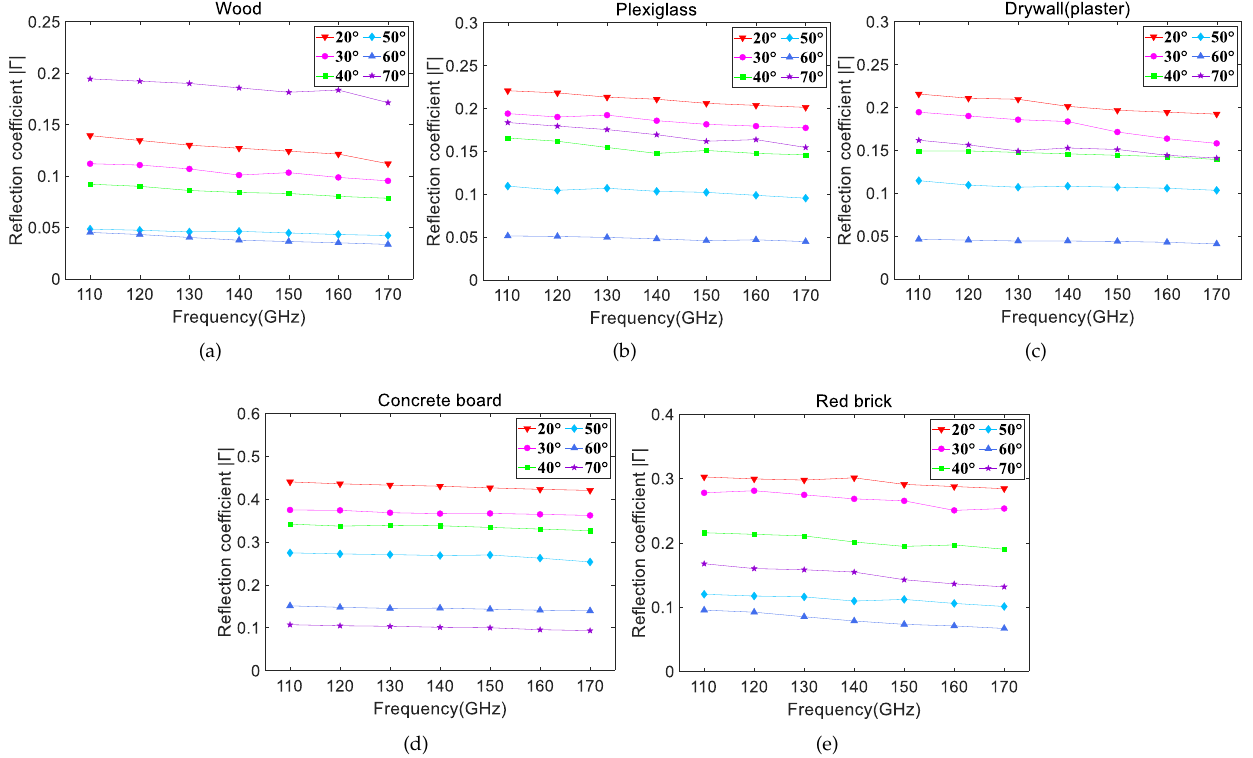
Figure 7. The relationship between measured reflection coefficients of five materials and frequencies in D-band. ( a ) Wood, ( b ) Plexiglass, ( c ) Drywall (plaster), ( d ) Concrete board, ( e ) Red